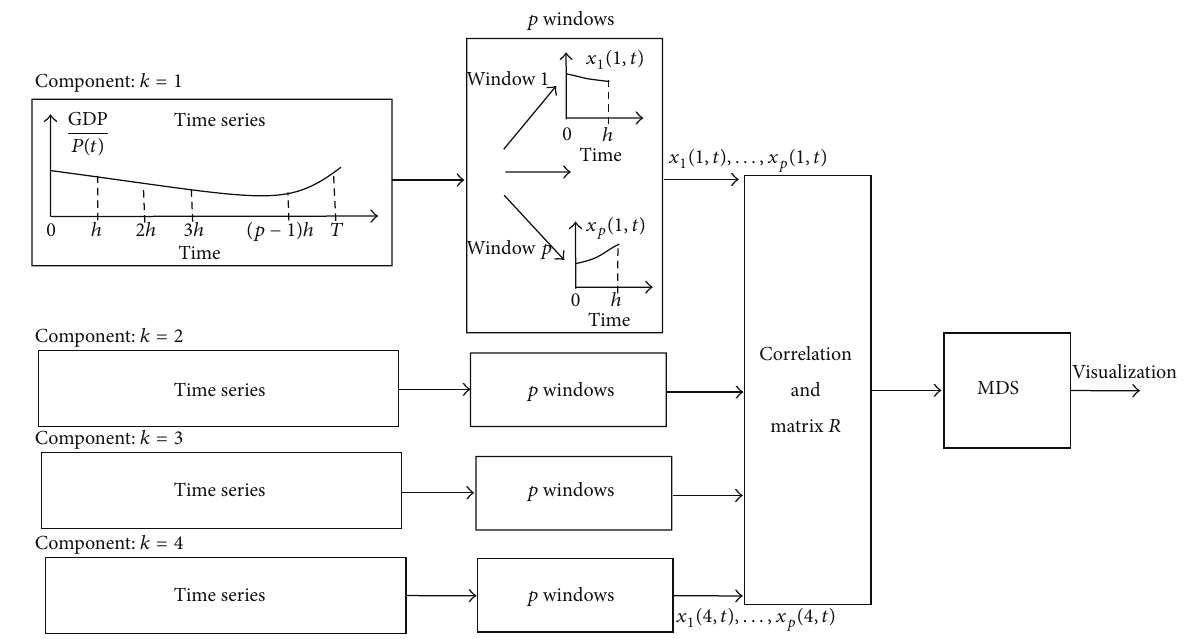
Figure 2: Diagram of the MDS visualization involving 𝑝 windows of 𝑘 max